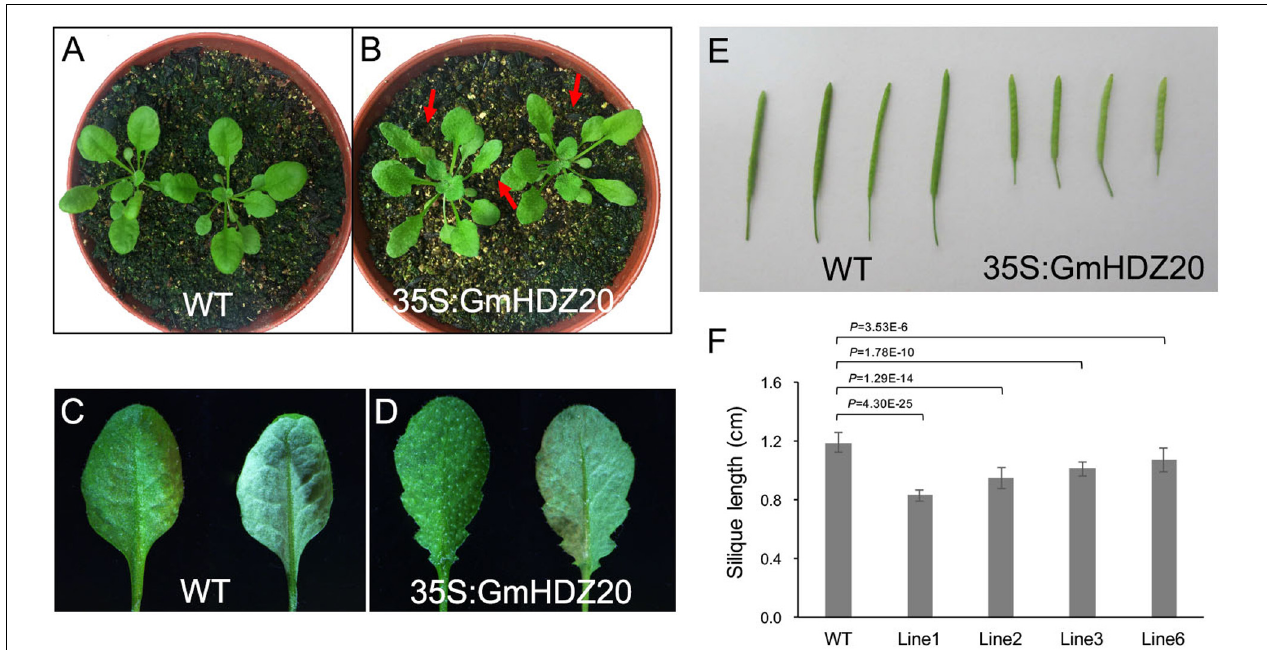
FIGURE 9 | Phenotypic characterization of 35S:GmHDZ20 Arabidopsis plants. (A) 3-week-old WT seedlings. (B) 3-week-old GmHDZ20 -expressing transgenic seedlings. (C) WT adaxial and abaxial leaf. (D) Adaxial and abaxial leaf of the GmHDZ20 -expressing transgenic plants. (E) Comparison of silique length between the WT and transgenic plants. (F) Statistics of silique length in WT and transgenic plants. Data are given as means ± SD ( n = 10 seedlings). Two-tailed, paired-sample t -tests were used to generate the p-